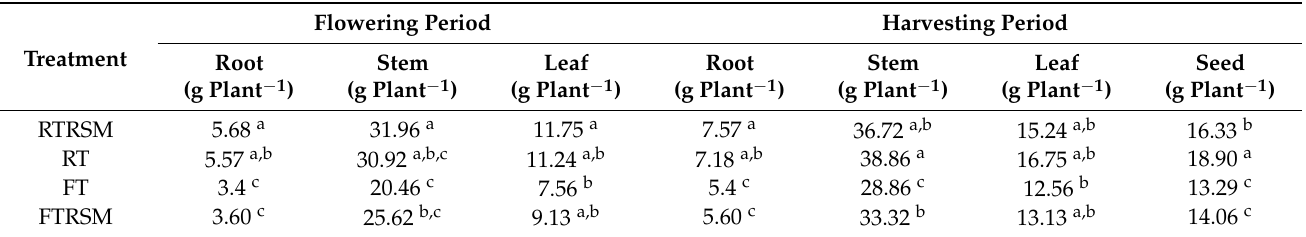
Table 4. The dry matter accumulation of faba bean in different organs under different treatments at different periods.